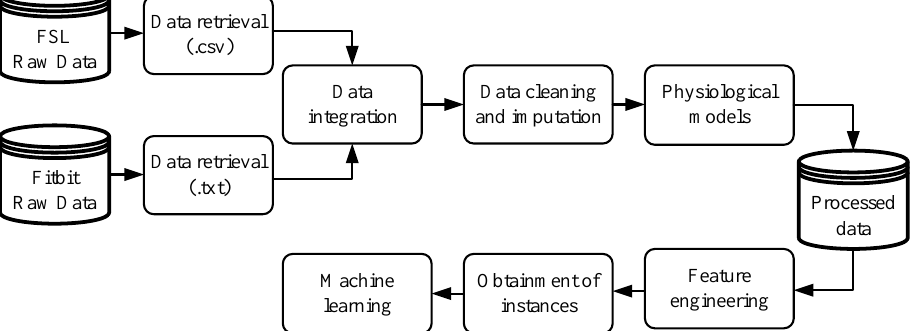
Figure 1. Methodology applied to prepare the data from FreeStyle Libre (FSL) and Fitbit for the application of machine-learning